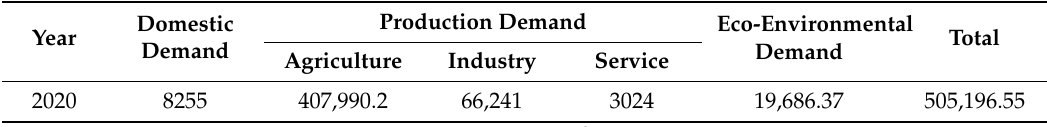
Table 3. Water demand prediction for Bayannur City in 2020.